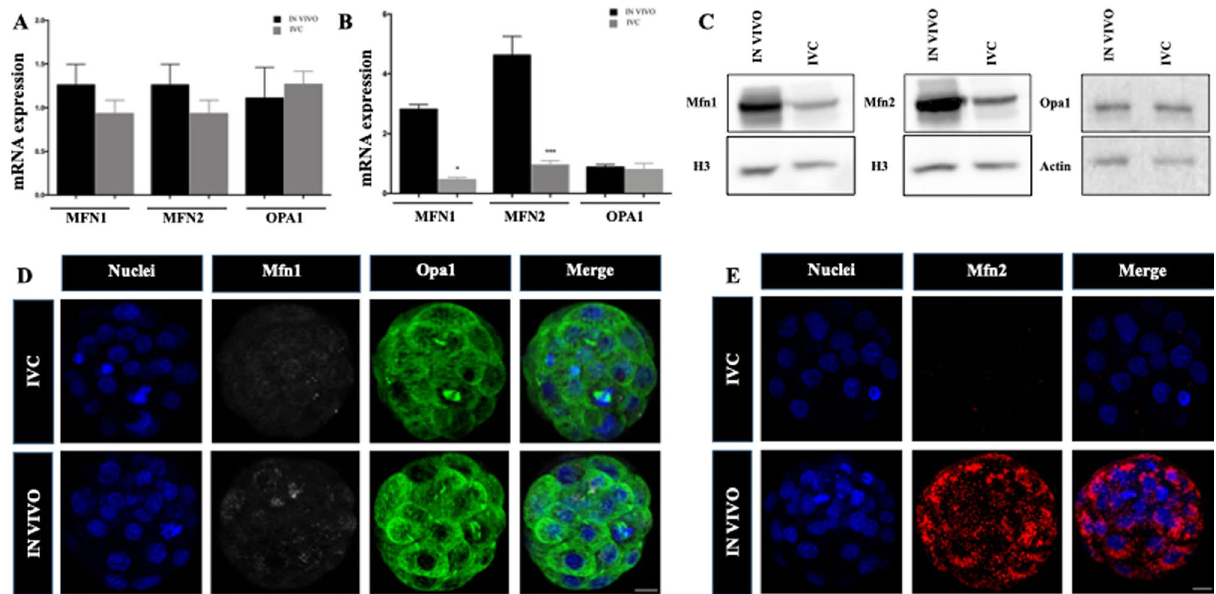
Figure 5. Mitochondrial fusion (Mfn1, Mfn2) and fission (Opa1) mRNA and proteins expression in mouse embryo. ( A ) Mfn1, Mfn2 and Opa1 gene expression detected by qPCR in 2-cell-stage and ( B ) blastocyst stage ( B ) embryos; ( C ) Protein expression of Mfn1, Mfn2 and Opa1 in IVC and IN VIVO blastocysts; ( D ) Mfn1 and Opa1 and ( E ) Mfn2 protein localisation determined by immunostaining in in vivo-developed and IVC blastocysts. Scale bars: 10